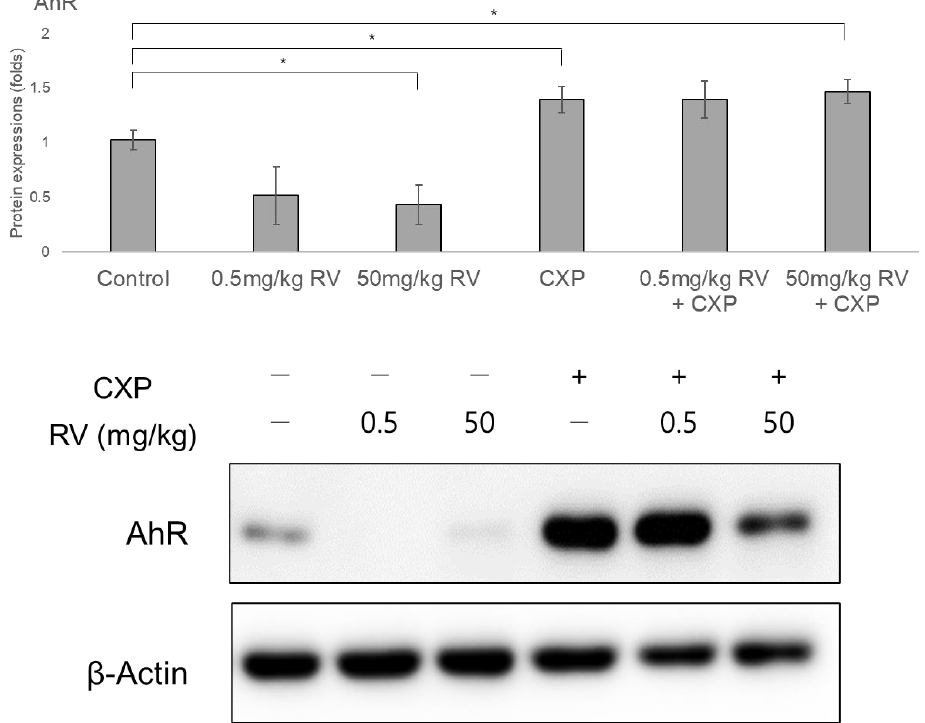
Figure 4. The administration of RV decreased the AhR protein levels. On the other hand, CXP administration increased the AhR protein level (* P < 0.05, compared to the control group).